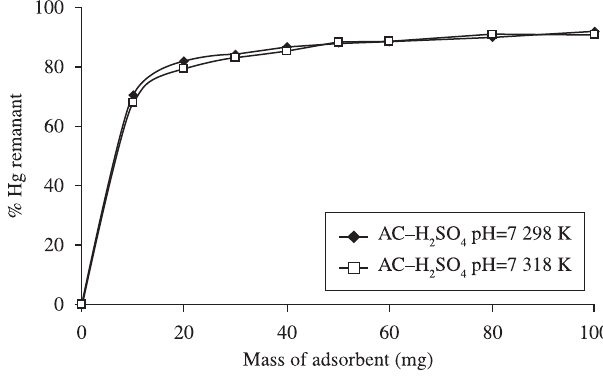
Figure 7. Effect of temperature on removal of Hg(II) for AC-H